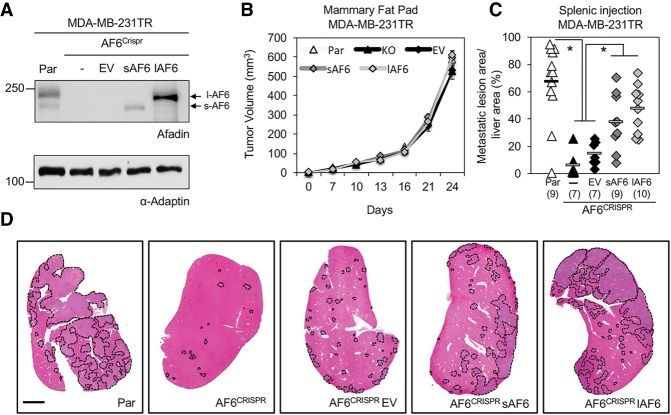
Afadin-deficient human breast cancer cells are impaired in their ability to metastasize to the liver. (A) A pooled population (n = 3 independent clones) of MDA-MB-231TR cells lacking Afadin (AF6Crispr) or harboring either an empty vector (EV), short Afadin (sAF6), or long Afadin (lAF6) were analyzed by immunoblot analysis, with α-Tubulin serving as a loading control. (B) Tumor growth in the mammary fat pad was measured for the cell populations described in A. (C) Liver metastatic burden (tumor area per tissue area) was analyzed following splenic injection of Afadin-proficient and Afadin-deficient MDA-MB-231TR breast cancer cells. (*) P < 2 × 10−3. (D) Representative images of the cardiac liver lobe for each cell population are shown. Metastatic lesions are outlined by dotted lines. Bar, 2 mm.